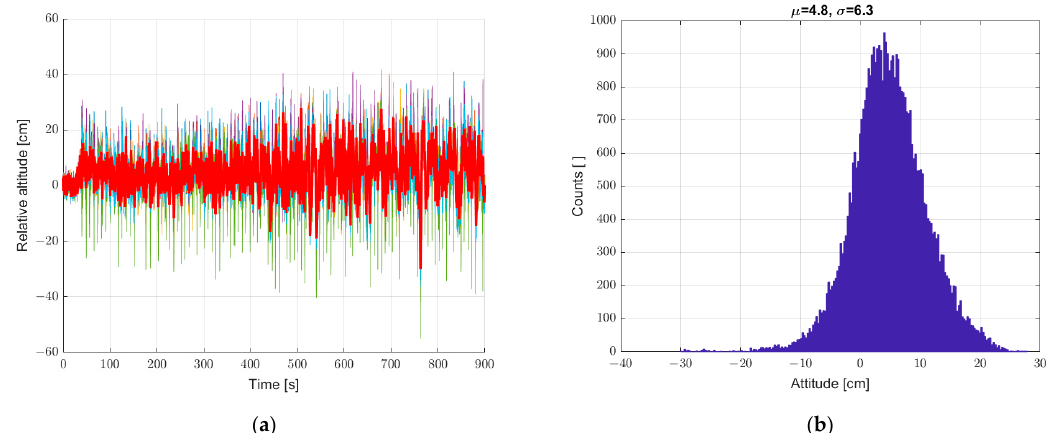
Figure 14. ( a ) Graph over time from 6 + 1 sensors, a bold graph calculated from the average of the individual sensors, and ( b ) histogram. Static measurements—sensor array at standstill, with additional variable crosswind gusts.